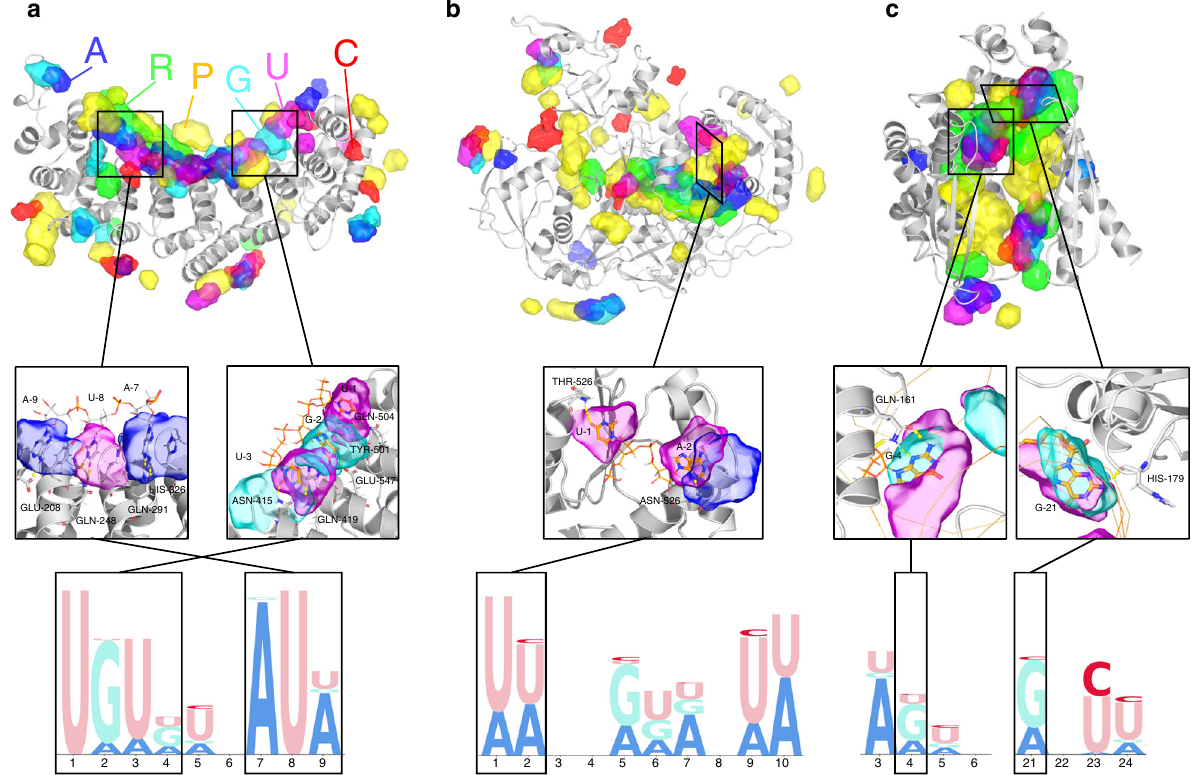
Fig. 3 NucleicNet prediction captures detailed binding motion determined by structural biology experiments. a FBF2, b hAgo2, and c Aa-RNase III. Upper panel: NucleicNet predictions for query RBPs. Top 10% of the binding sites are drawn in transparent surfaces for each class. Color code: phosphate-yellow, ribose-green, adenine-blue, cytosine-red, guanine-cyan, uracil-purple, and protein-gray cartoon. Middle panel: detailed view on chemical interactions. Lower panel: predicted sequence logo diagrams for respective